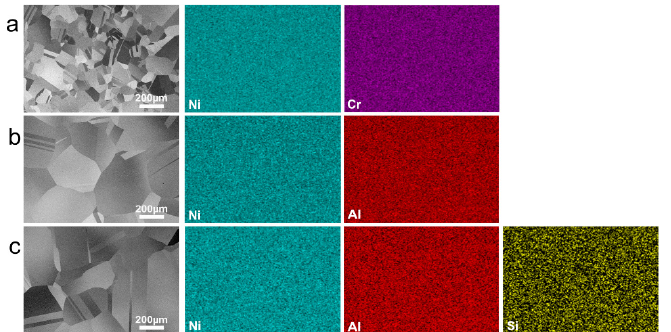
Figure 1. Initial microstructures (BSE images) and corresponding EDS maps of ( a ) Ni-20Cr, ( b ) Ni- 15Al, and ( c ) Ni-15Al-2Si before oxidation experiments. Note that all three model alloys are Ni-based solid-solution alloys with uniformly distributed elements despite different grain sizes.